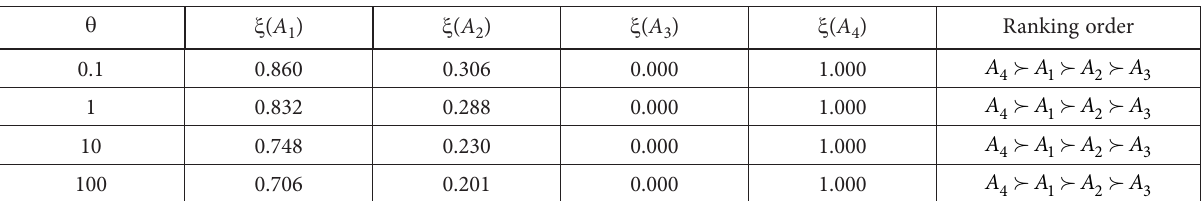
Table 7. Sensitivity analysis results by the improved TODIM